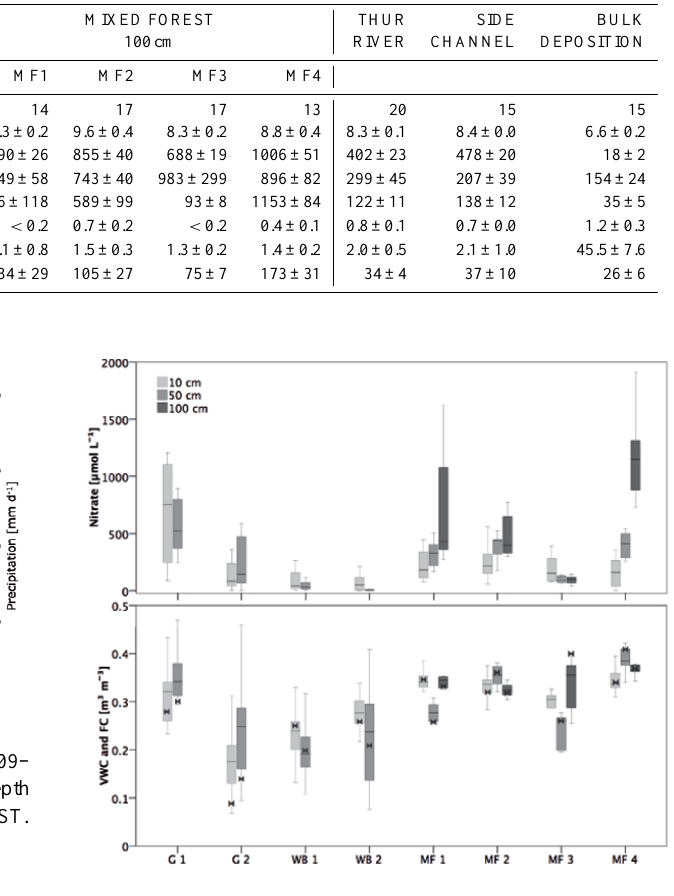
Fig. 4. (Above) Boxplot of nitrate concentrations of the pooled sam- ples for different plots and depths showing the minimum value, lower quartile, median, upper quartile, and maximum value. Out- liers (±3 standard deviation) are not shown. (Below) Boxplots of VWCs for periods when soil solutions were taken (average of half- hourly measurements over 2–3 days). Crosses indicate the field ca- pacity (FC) for the corresponding soil